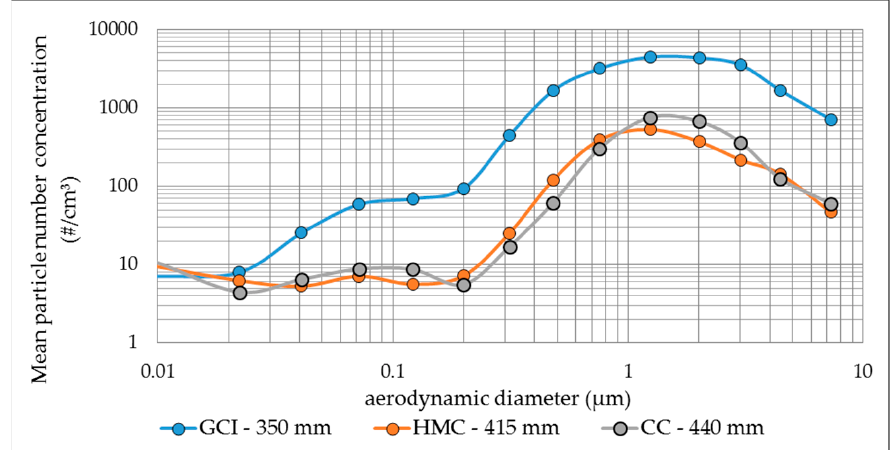
Figure 8. Mean particle size distribution of different friction materials (vehicle 2)—WLTP brake cycle trip #10.